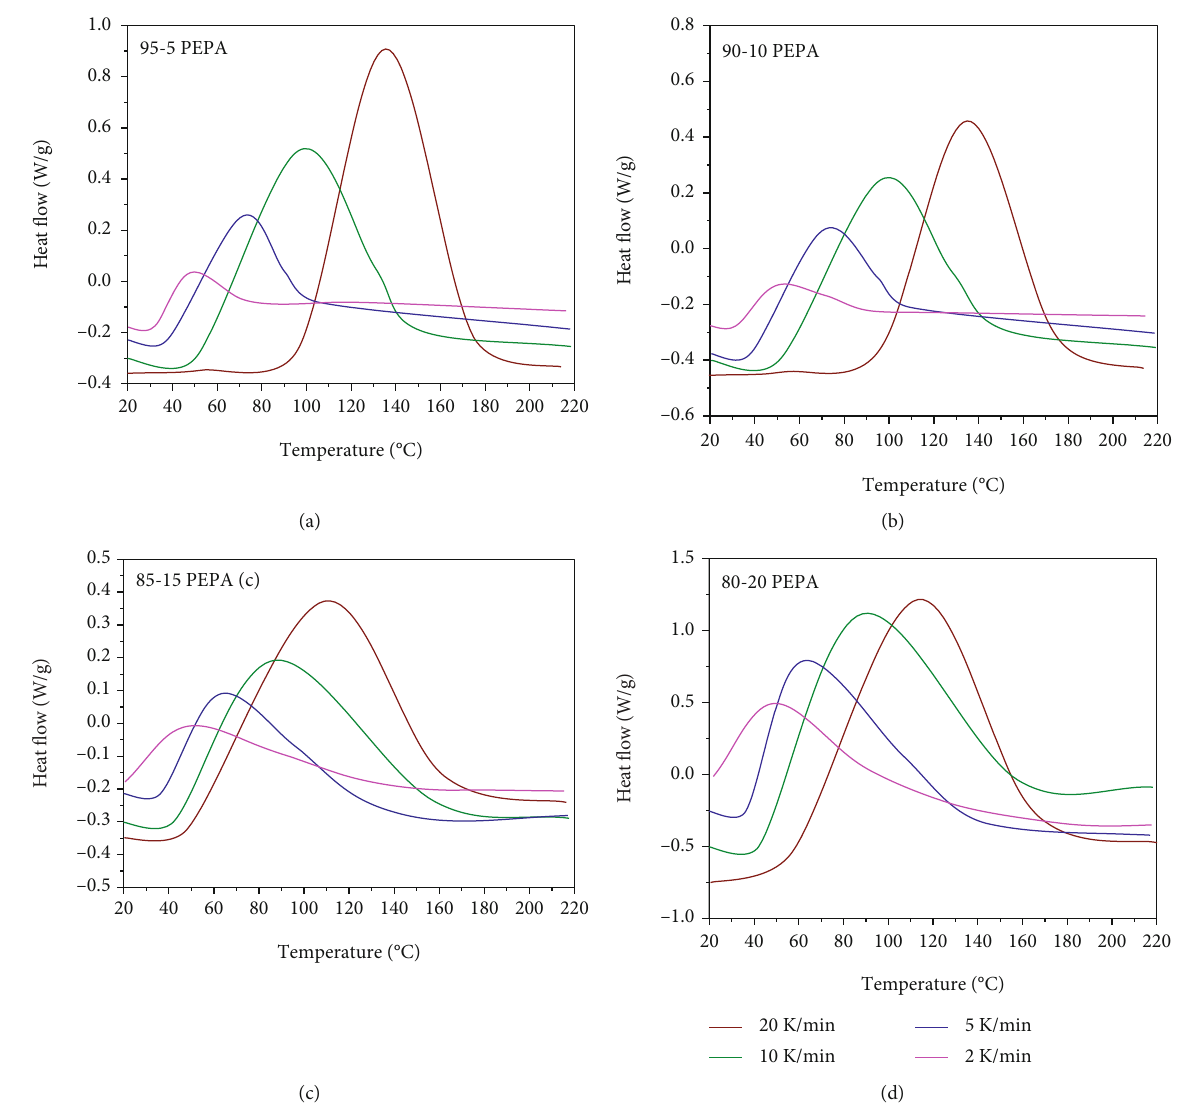
Figure 3: Di ff erential scanning calorimetry curves of polyethylene polyamine: (a) 95-5; (b) 90-10; (c) 85-15; (d)